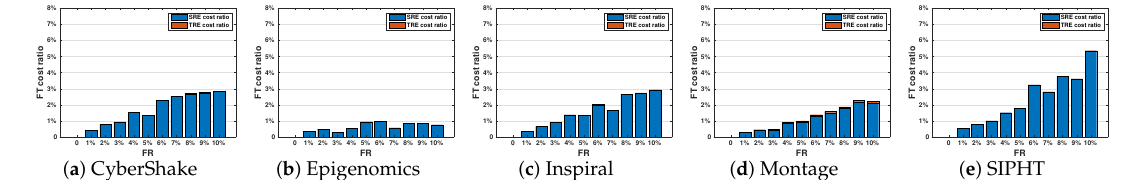
Figure 5. Fault-tolerant (FT) cost ratio of workflows with the increasing failure rate (FR).